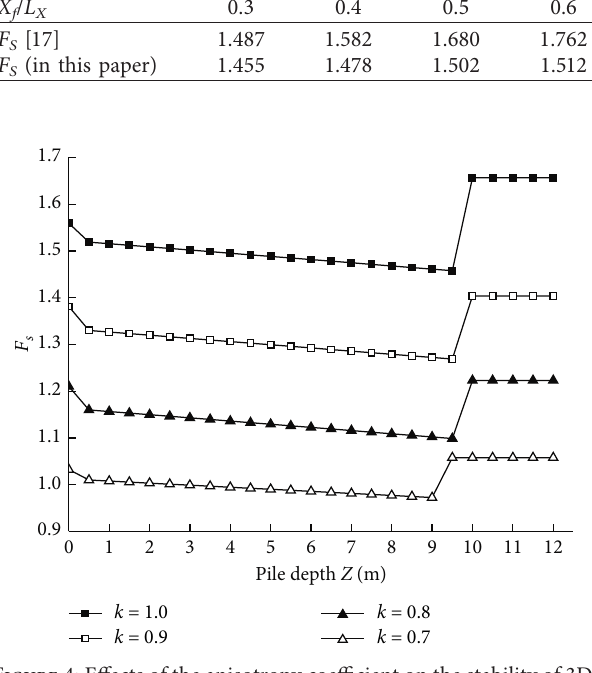
Figure 4: Effects of the anisotropy coefficient on the stability of 3D slopes.